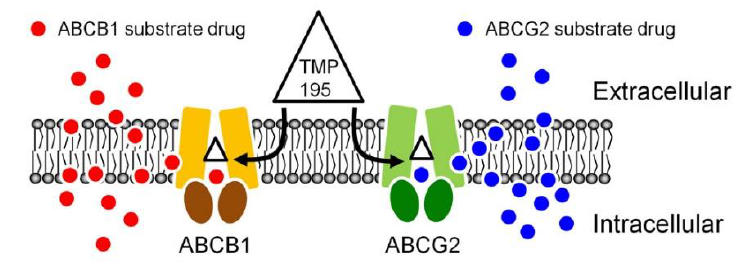
Figure 7. A simplified schematic diagram of TMP195 reversing drug resistance in cancer cells overexpressing ABCB1 or ABCG2 by attenuating the function of ABCB1 and ABCG2. The ATP-binding cassette proteins ABCB1 (brown) and ABCG2 (green) reduce intracellular drug concentration by actively transporting ABCB1 substrate drug (red circles) and ABCG2 substrate drug (blue circles) out of the cancer cell, which leads to multidrug resistant phenotype. By binding to the drug-binding pocket(s) of ABCB1 and ABCG2, TMP195 (triangle) attenuates the drug efflux function of both ABCB1 and ABCG2, thus restoring the chemosensitivity of cancer cells to these chemotherapeutic drugs.